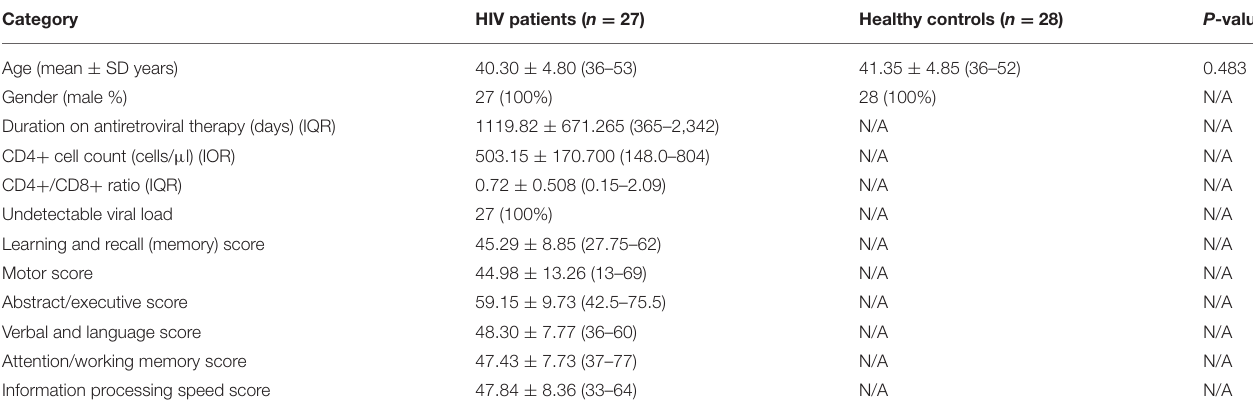
TABLE 1 | Demographic and clinical characteristics of patients with HIV and healthy controls.